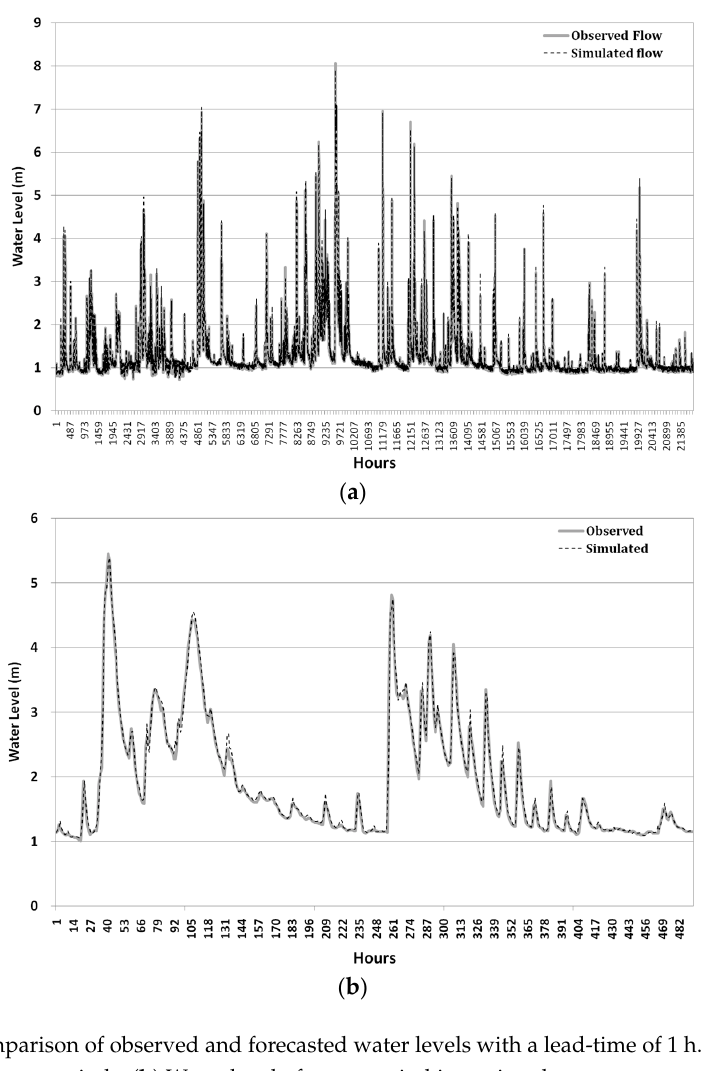
Figure 10. Comparison of observed and forecasted water levels with a lead-time of 1 h. ( a ) Water level of training and test periods; ( b ) Water level of some period in testing data set.